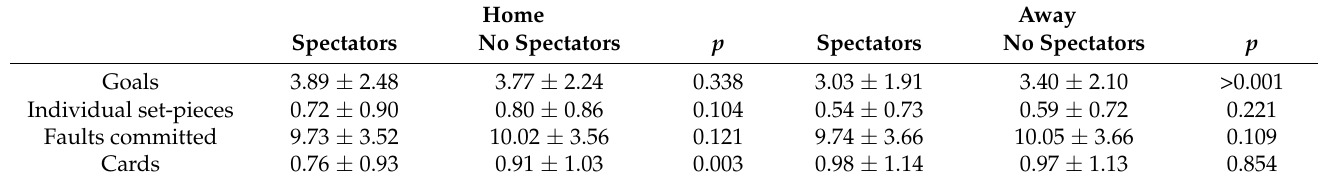
Table 2. Descriptive analysis of match variables according to match location and spectators pres- ence. The data represents events per match for each team and are shown as mean ± SD.